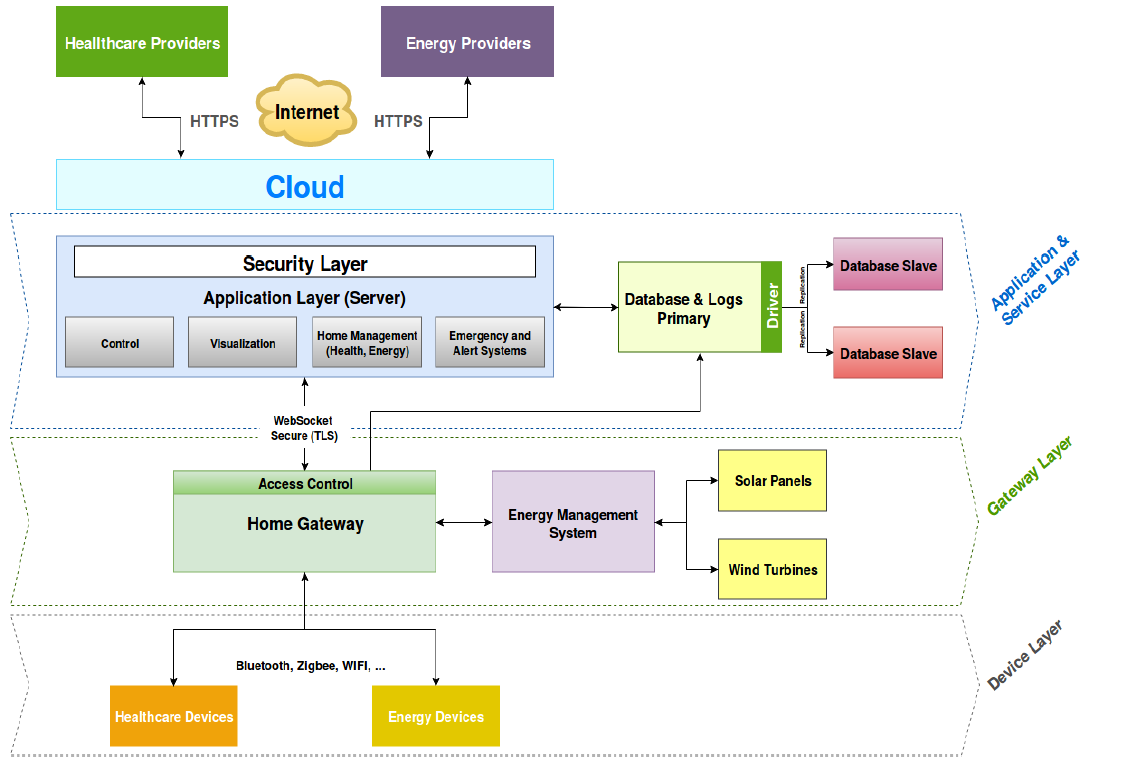
Figure 3. Next generation smart home